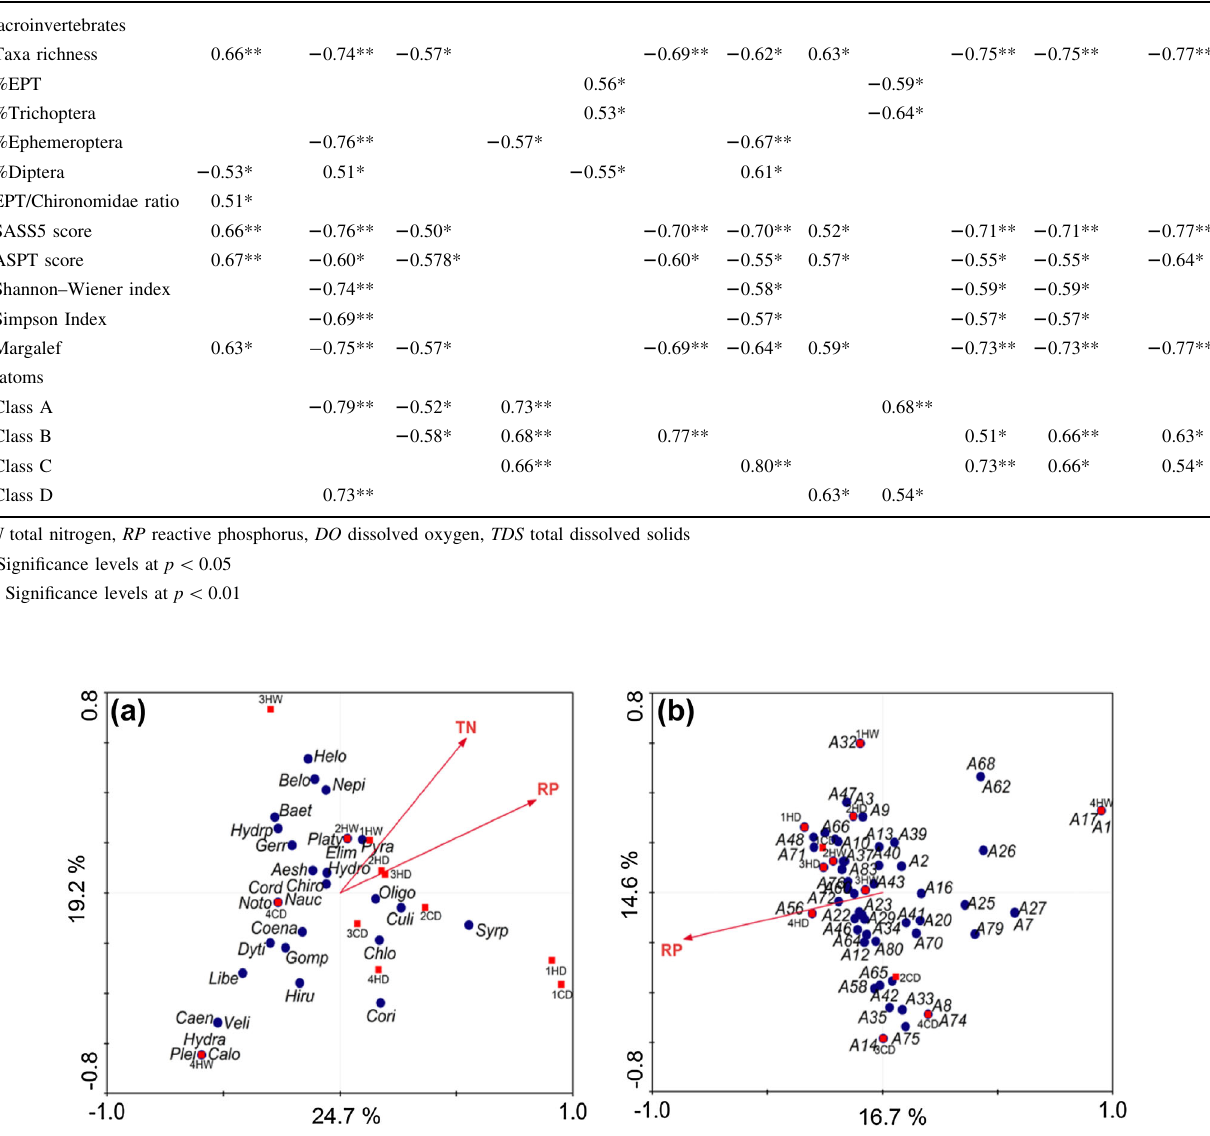
Fig. 2 CCA triplot showing the effects of environmental variables on: a macroinvertebrates and b diatom community structure in the Ngamo River. CD cool-dry, HW hot-wet, HD hot-dry. The numbers